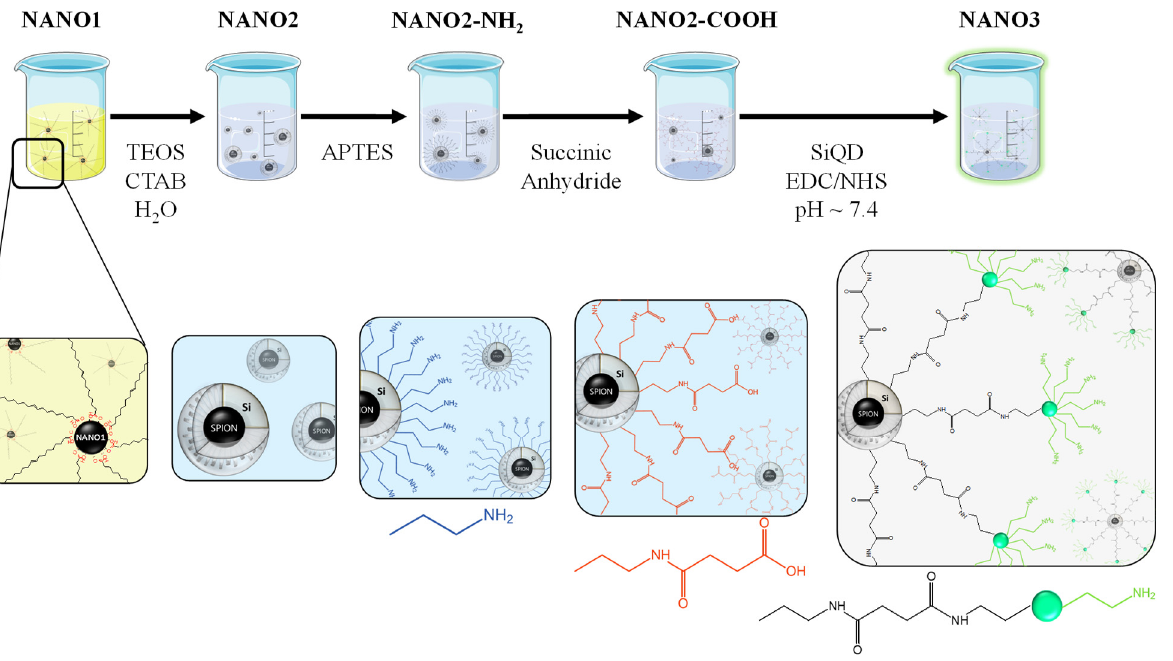
Figure 1. Sequential representation of the step-by-step synthesis of NANO3, from the formation of NANO1, and dispersion in CHCl 3 , to the growth of a mesoporous silica shell (NANO2) in water, further surface modifications (NANO2-NH 2 and NANO2-COOH) and SiQD anchoring via amidation. Representations not at real scale.